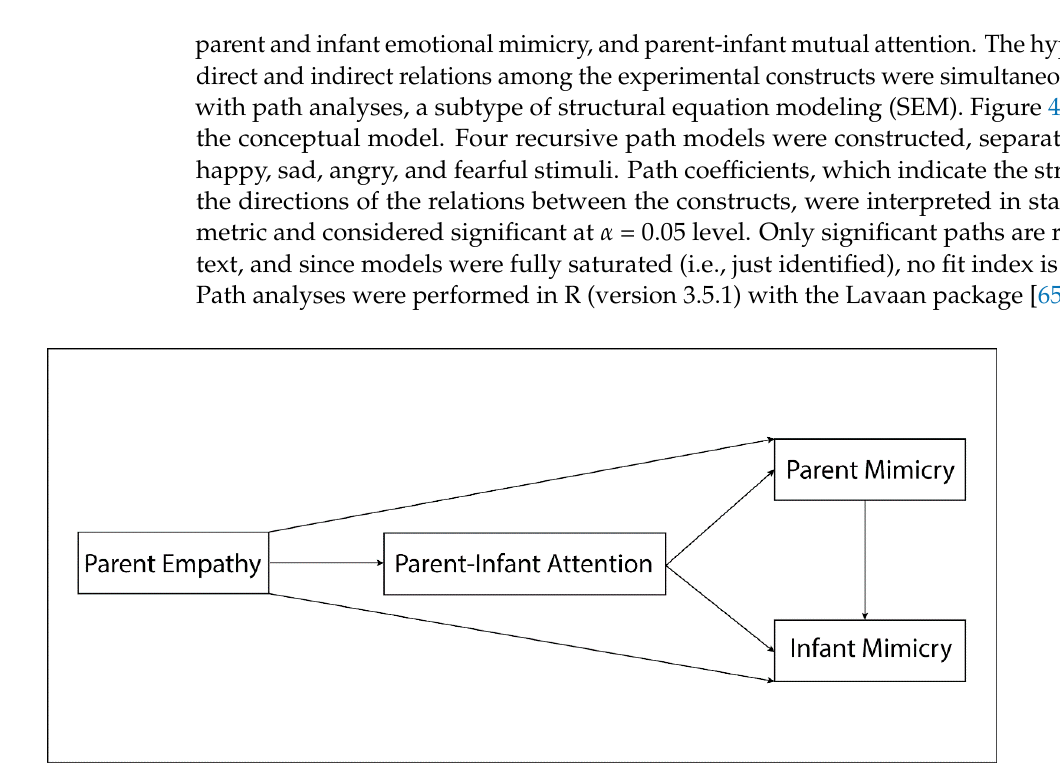
Figure 4. Conceptual path model linking infant emotional mimicry, parent emotional mimicry, parent-infant mutual attention, and parent dispositional empathy.